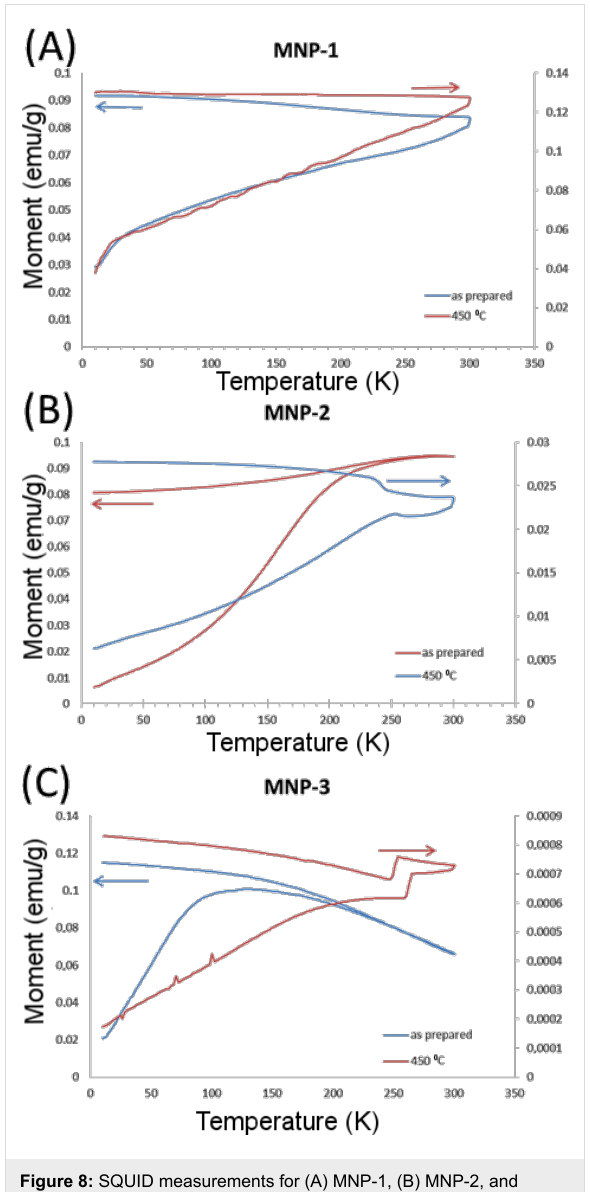
Figure 8: SQUID measurements for (A) MNP-1, (B) MNP-2, and (C)